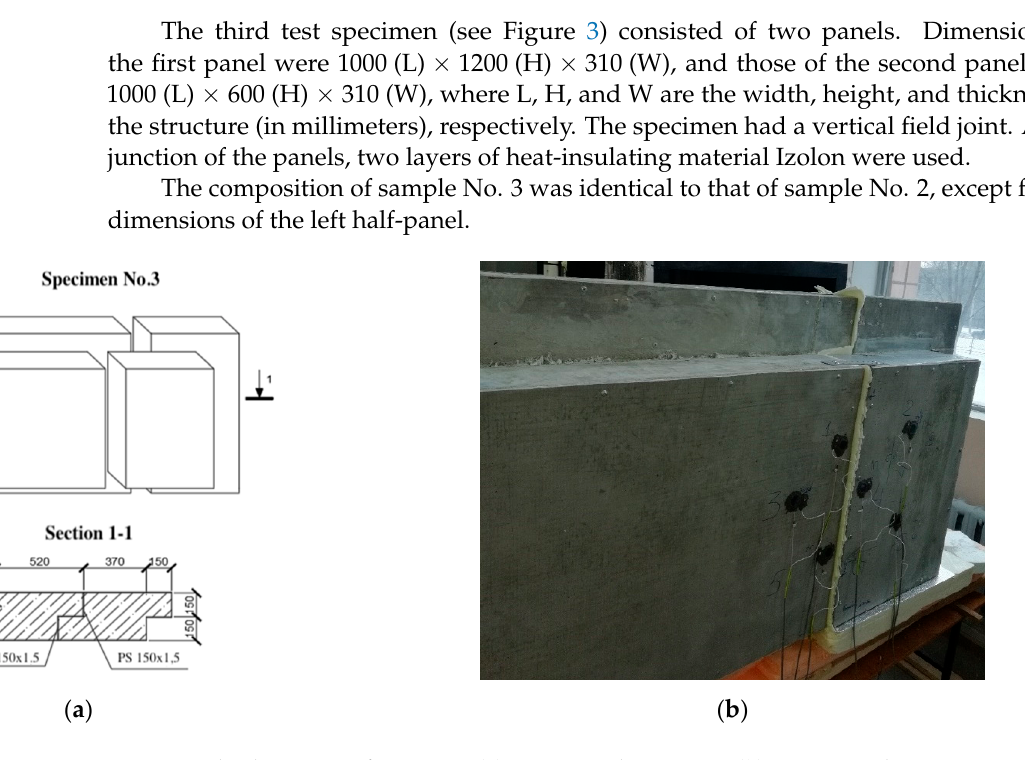
Figure 3. Third specimen for testing. ( a ) Specimen dimensions; ( b ) specimen photo.